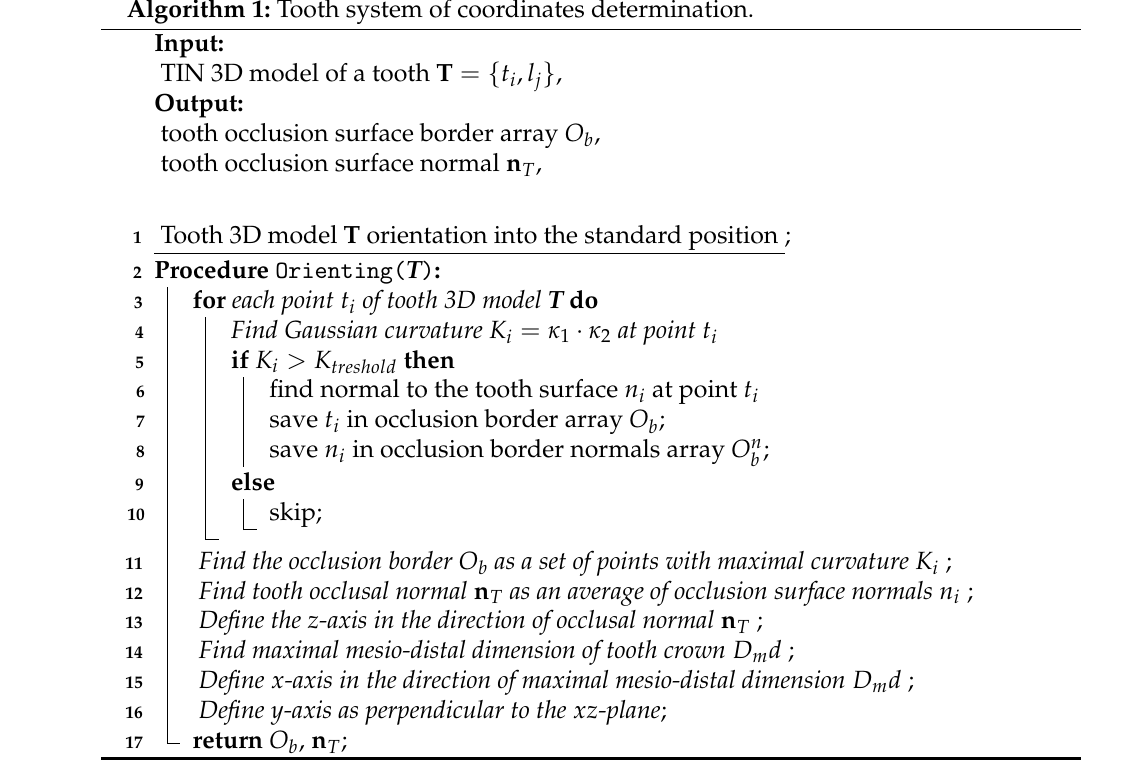
Algorithm 1: Tooth system of coordinates